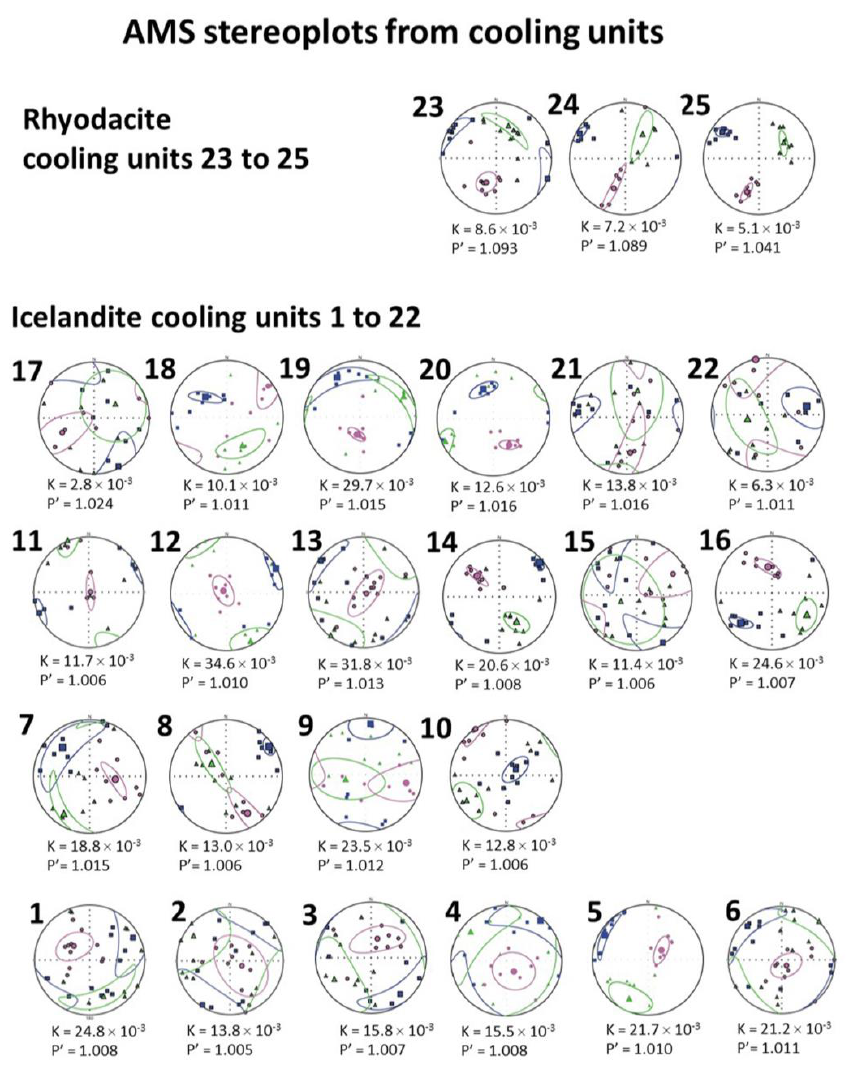
Figure 3. Stereoplots of the AMS from all cooling units, 1–25. Data are represented in lower hemisphere with maximum (squares), intermediate (triangles) and minimum (circles) principal axis of magnetic susceptibility. The tensorial mean directions and their ellipses of confidence calculated according to [29].